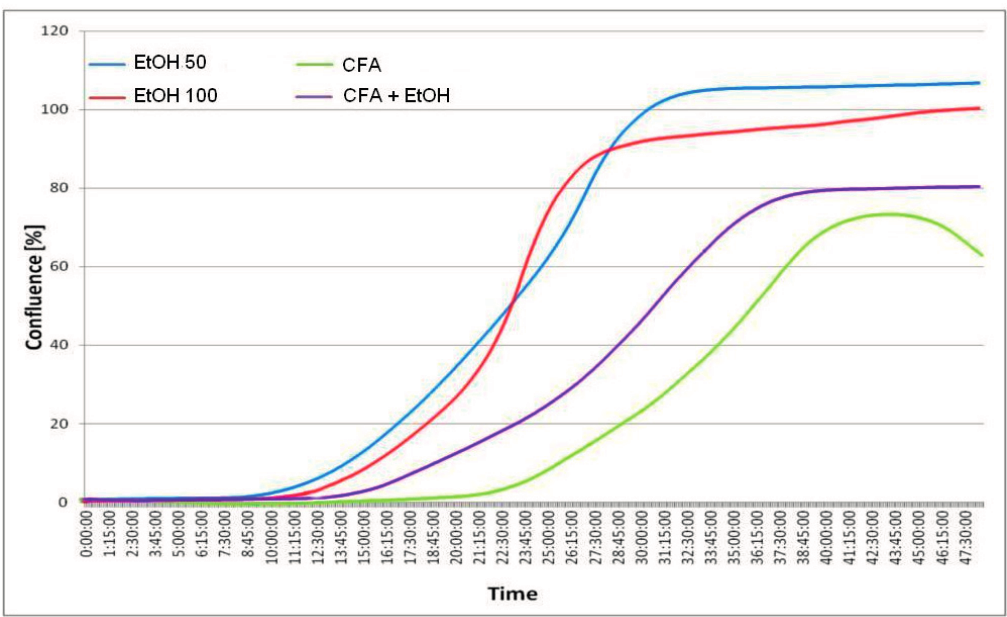
Figure 6. Time vs. % confluence function curves (graph below). Only about 5% wound closure is visible after 12 h for EtOH and lack of closure for CFA agent and CFA/EtOH mixture. Complete or almost complete closure occurs after 30 h for EtOH 50 mmol/L and EtOH 100 mmol/L, while CFA (50 μ mol/L) significantly effects migration of cancer cells, with only 20%–40% of wound closure after 30 h. The least closure (below 80%) is observed for pure CFA (50 μ mol/L) agent after 48 h. The selected images are representative of the experiment